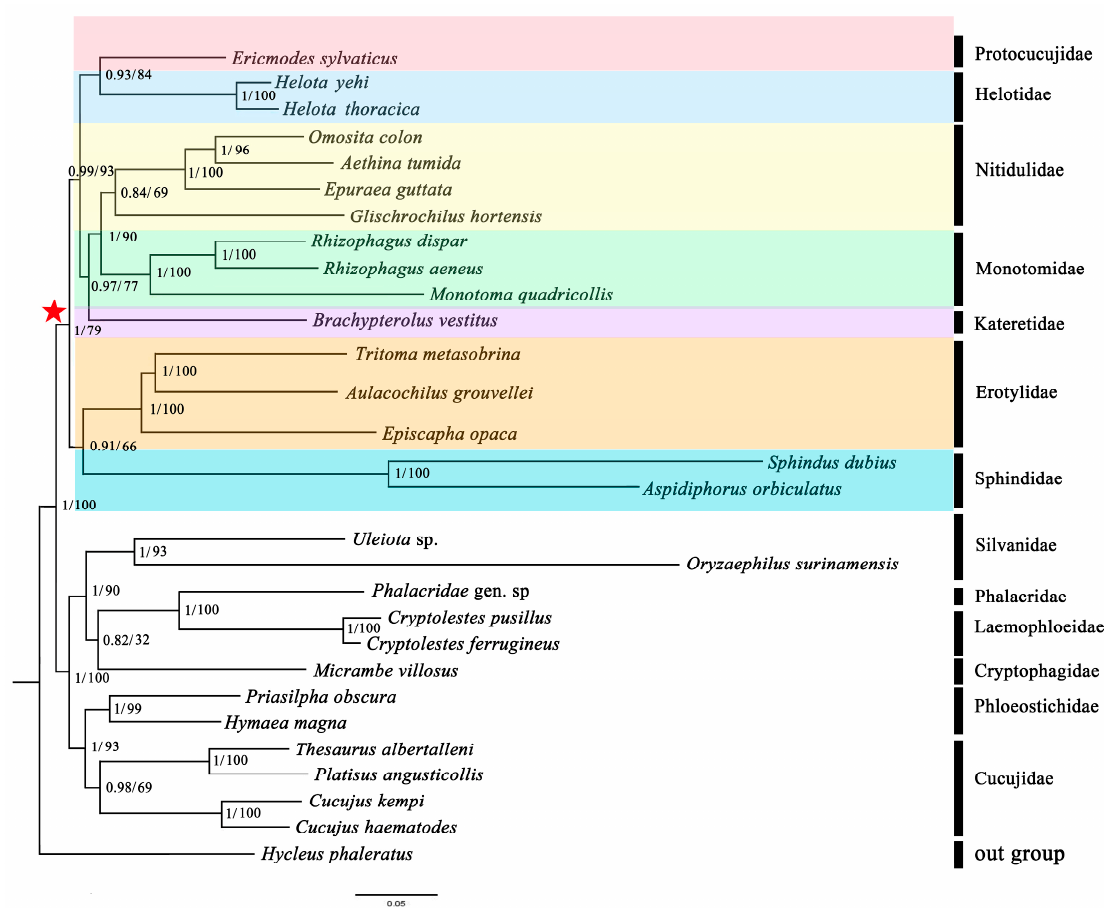
Figure 10. Phylogenetic relationships of the 13 basal families of Cucujoidea. Shown here is the phylogeny inferred from the PCG using Phylobayes v3.2 and the PCG12 dataset using IQ-tree v1.6.8. The number on the left represents the posterior probabilities (PP) from PhyloBayes v3.2 analysis and the number on the right represents ultrafast bootstrap support (BS, %) from IQ-Tree v1.6.8 analysis. The pentagram represents the location of phylogenetic relationships of the seven families.